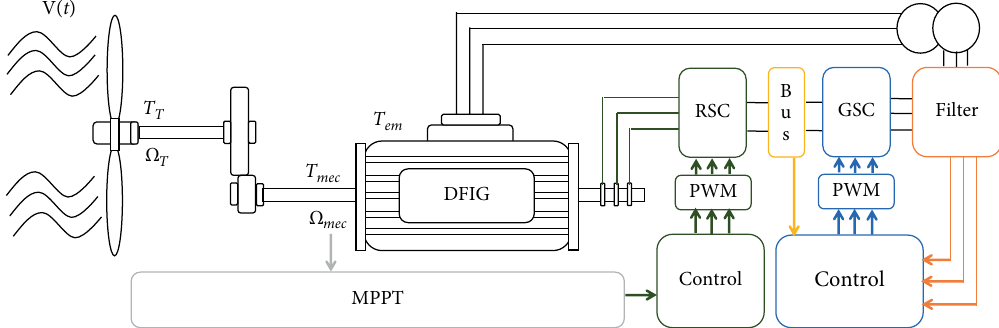
Figure 1: Schematic diagram of WECS based on